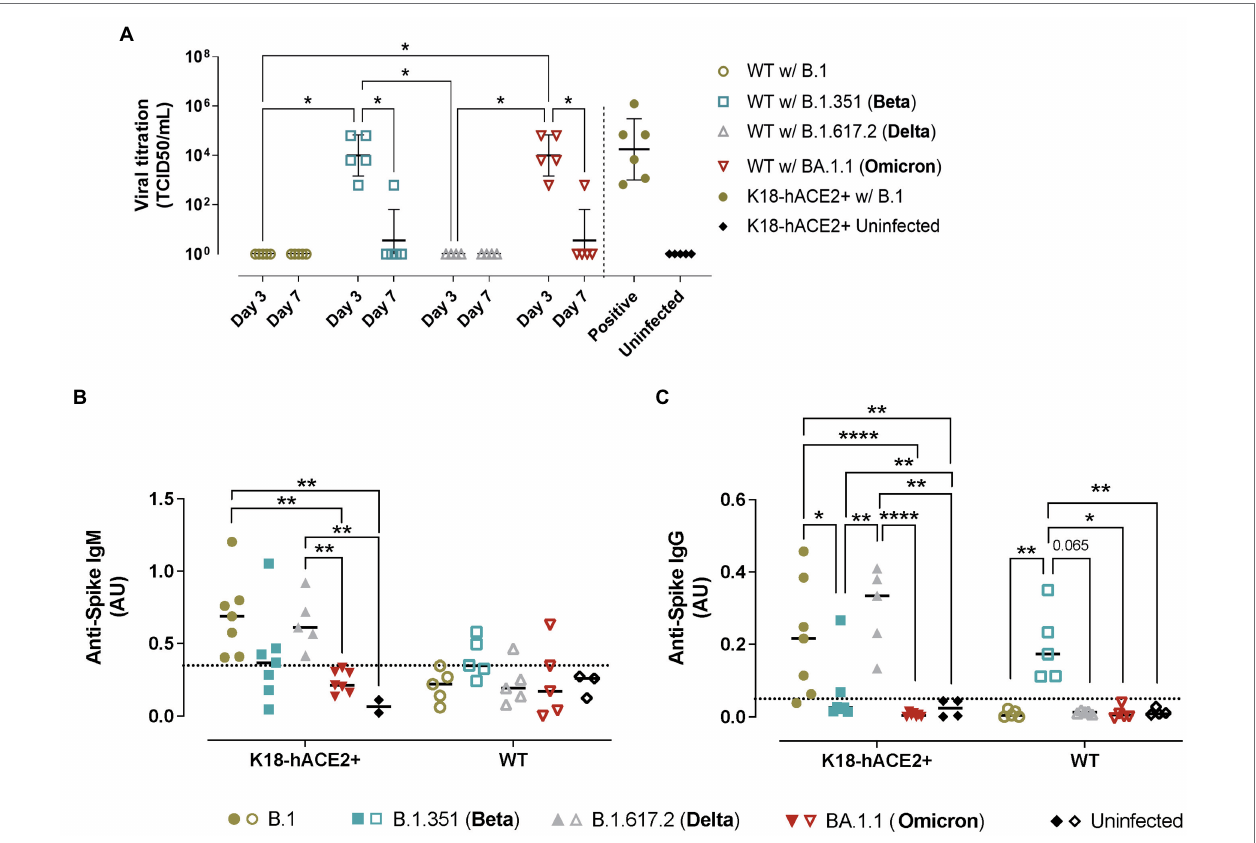
FIGURE 5 | Viral titration and humoral immune responses in hACE2+ and hACE2- mice infected with different SARS-CoV-2 variants. K18-hACE2 transgenic mice (solid symbols) and WT mice (empty symbols) were infected with SARS-CoV-2 B.1 (gold), B.1.351/Beta (blue), B.1.617.2/Delta (grey) and BA.1.1/Omicron (red) variants. (A) Viral load of replicative virus (TCID 50 ) recovered from lung samples from SARS-CoV-2-infected mice at endpoint in Vero E6 cells at day 5 of culture. For statistical analysis, all data below the limit of detection (Holmes et al., 2021) were censored. Statistically significant differences were identified